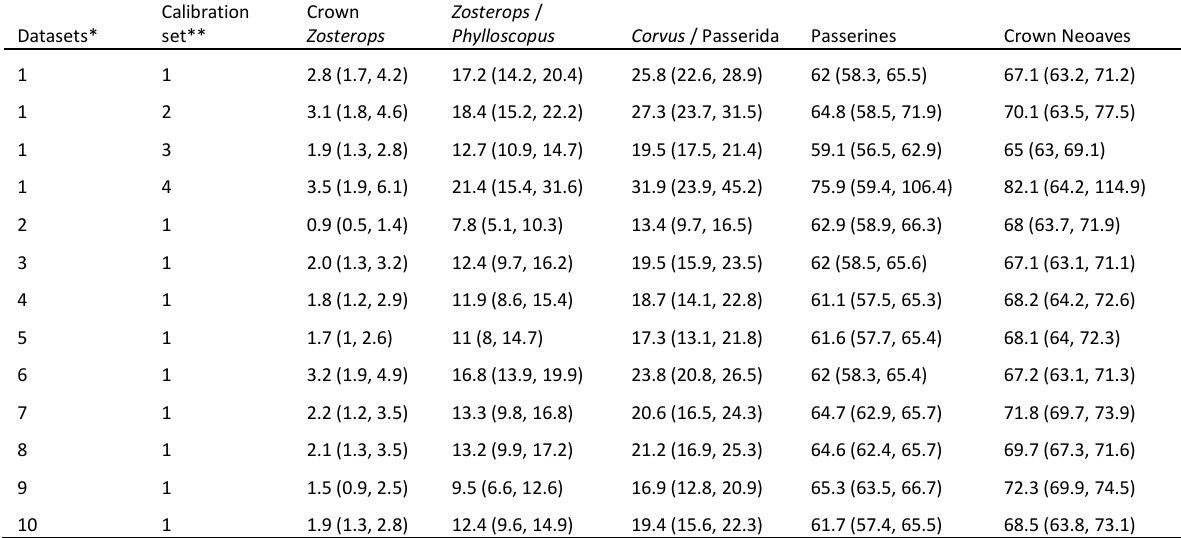
Table 1. Molecular dating analyses. Mean dates are indicated and 95% confidence intervals (CI) are provided within parentheses Datasets*